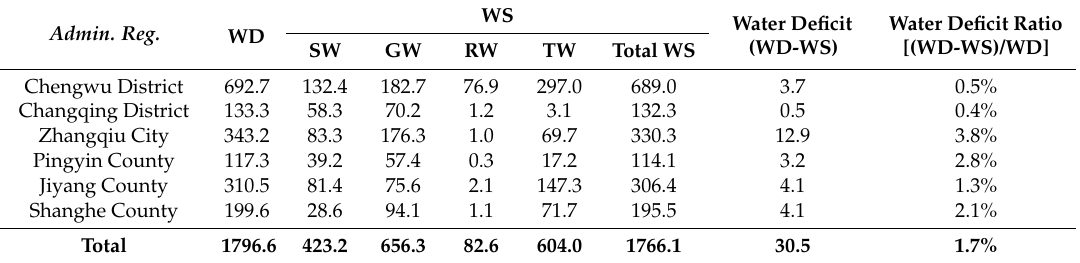
Table 5. Off-stream water balance between water supply and demand in the base year (units: million m 3 ). WS Water Deficit Water Deficit Ratio Admin. Reg. WD (WD-WS) [(WD-WS)/WD]SW GW RW TW Total WS Chengwu District